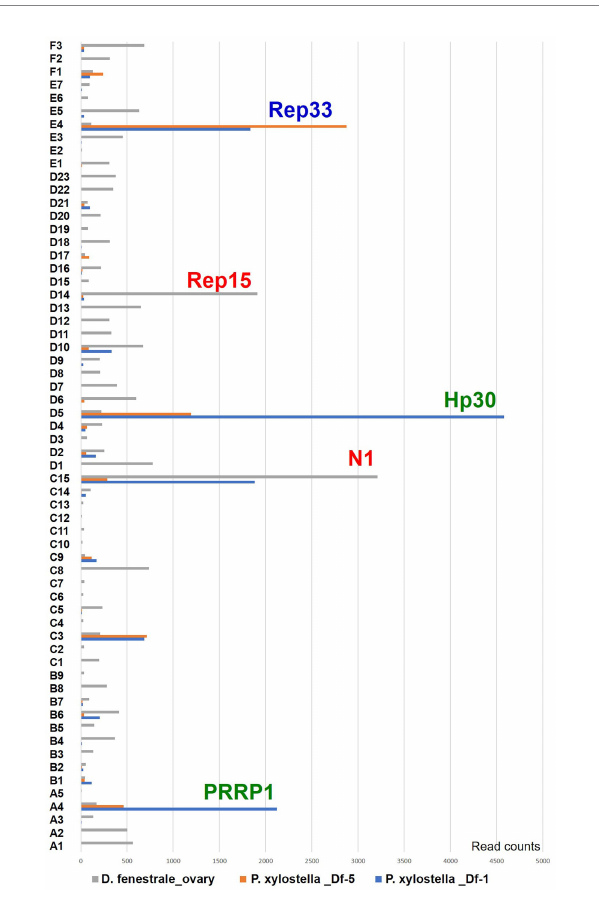
FIGURE 4 Gene expression pattern in two different hosts (hymenopteran host, Diadegma fenestrale, and lepidopteran host, Plutella xylostella ) and developmental stages of P. xylostella based on RNAseq. The segments are expressed in the ovaries of hymenopteran host, D. fenestrale ; only two segments (C15 and D14) were highly expressed in D. fenestrale ovaries. Five segments (E4, D5, C15, C3, and A4) were differentially expressed according to the developmental stage of P. xylostella (1 and 5 days after parasitization by D. fenestrale ; third and fourth larval